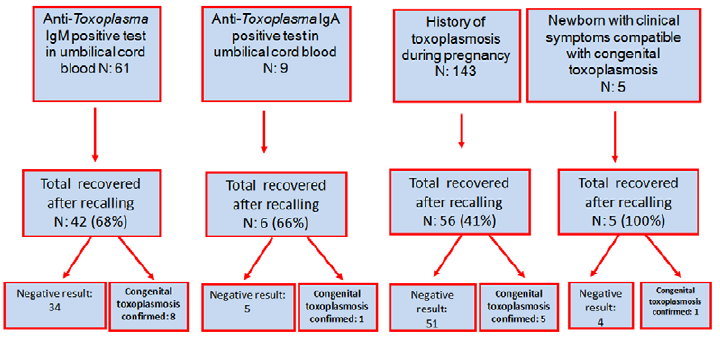
Figure 2. Flowchart and results of the postnatal confirmatory tests at the follow up.